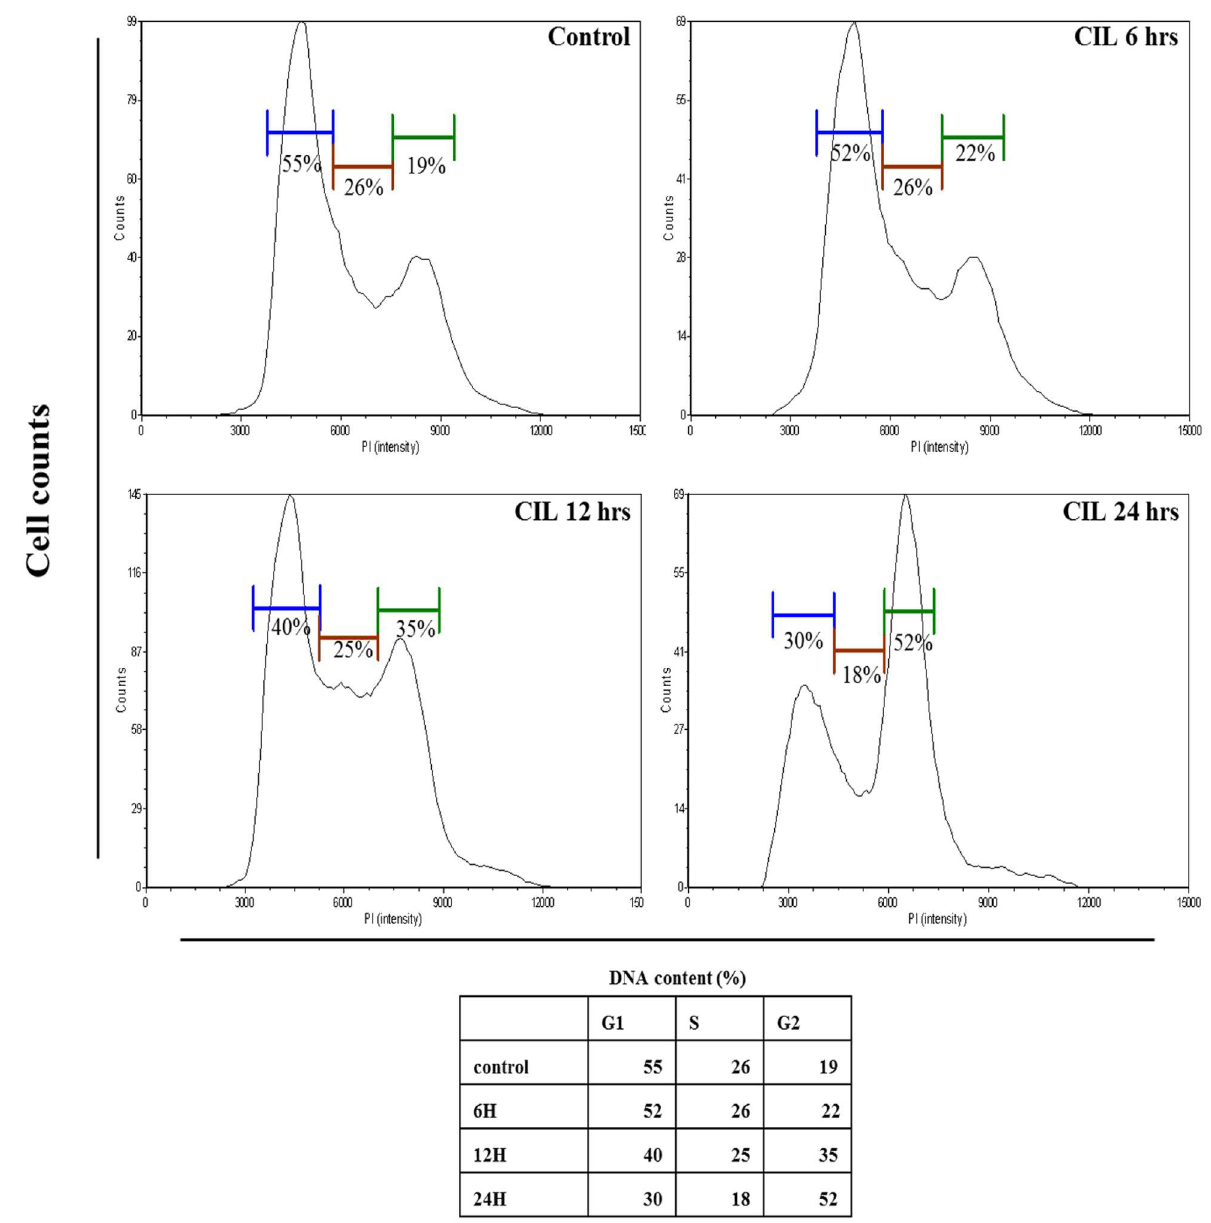
Fig 3. Effect of CIL-102 on cell cycle distribution in DLD-1 cells. (A) After treatment with ErinacineA (1 mM) for 24 h, the cells were fixed and stainedwith propidiumiodide, and the DNA content was analyzedby flow cytometry (FACS). The cell number percentage in each phase(G1, S, and G2/M) of cell cycle was calculatedand